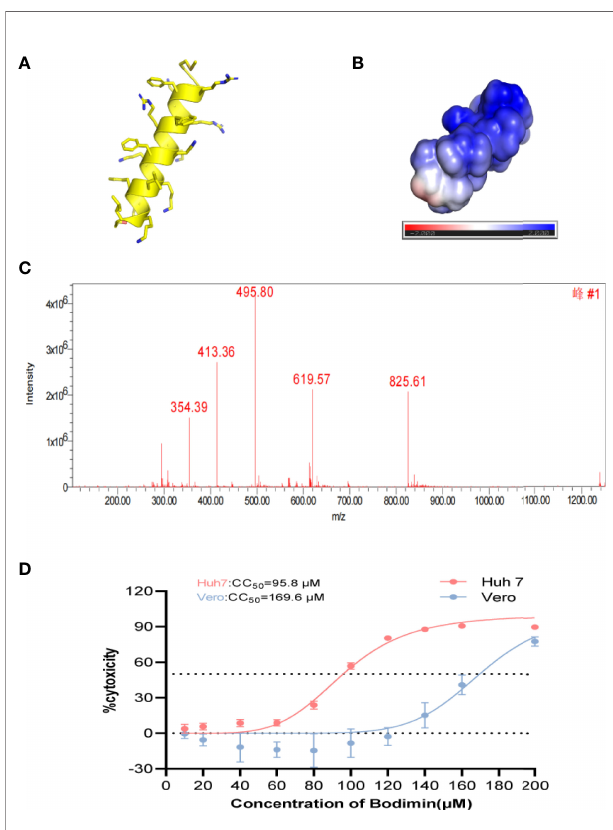
FIGURE 1 | The structural characteristics of bomidin. (A) The a -helix of bomidin. (B) Total solvent accessibility of bomidin; blue, hydrophobic; red, hydrophilic regions. (C) Mass analysis of bomidin. (D) Cytotoxic effects of bomidin in cells. The cytotoxicity induced by bomidin in Vero E6 and Huh7 cells was determined by CCK-8 assay 48 h after treatment. CC50 is the bomidin concentration required to reduce cell viability by